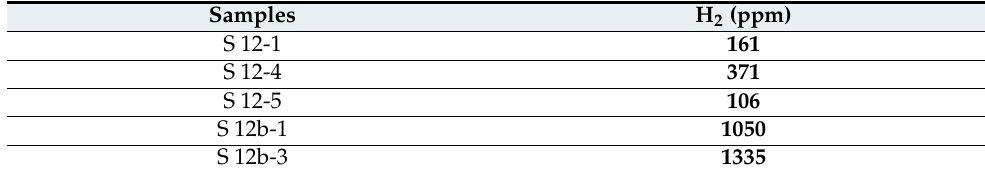
Table 3. H 2 from GC in the fumaroles of Sol de